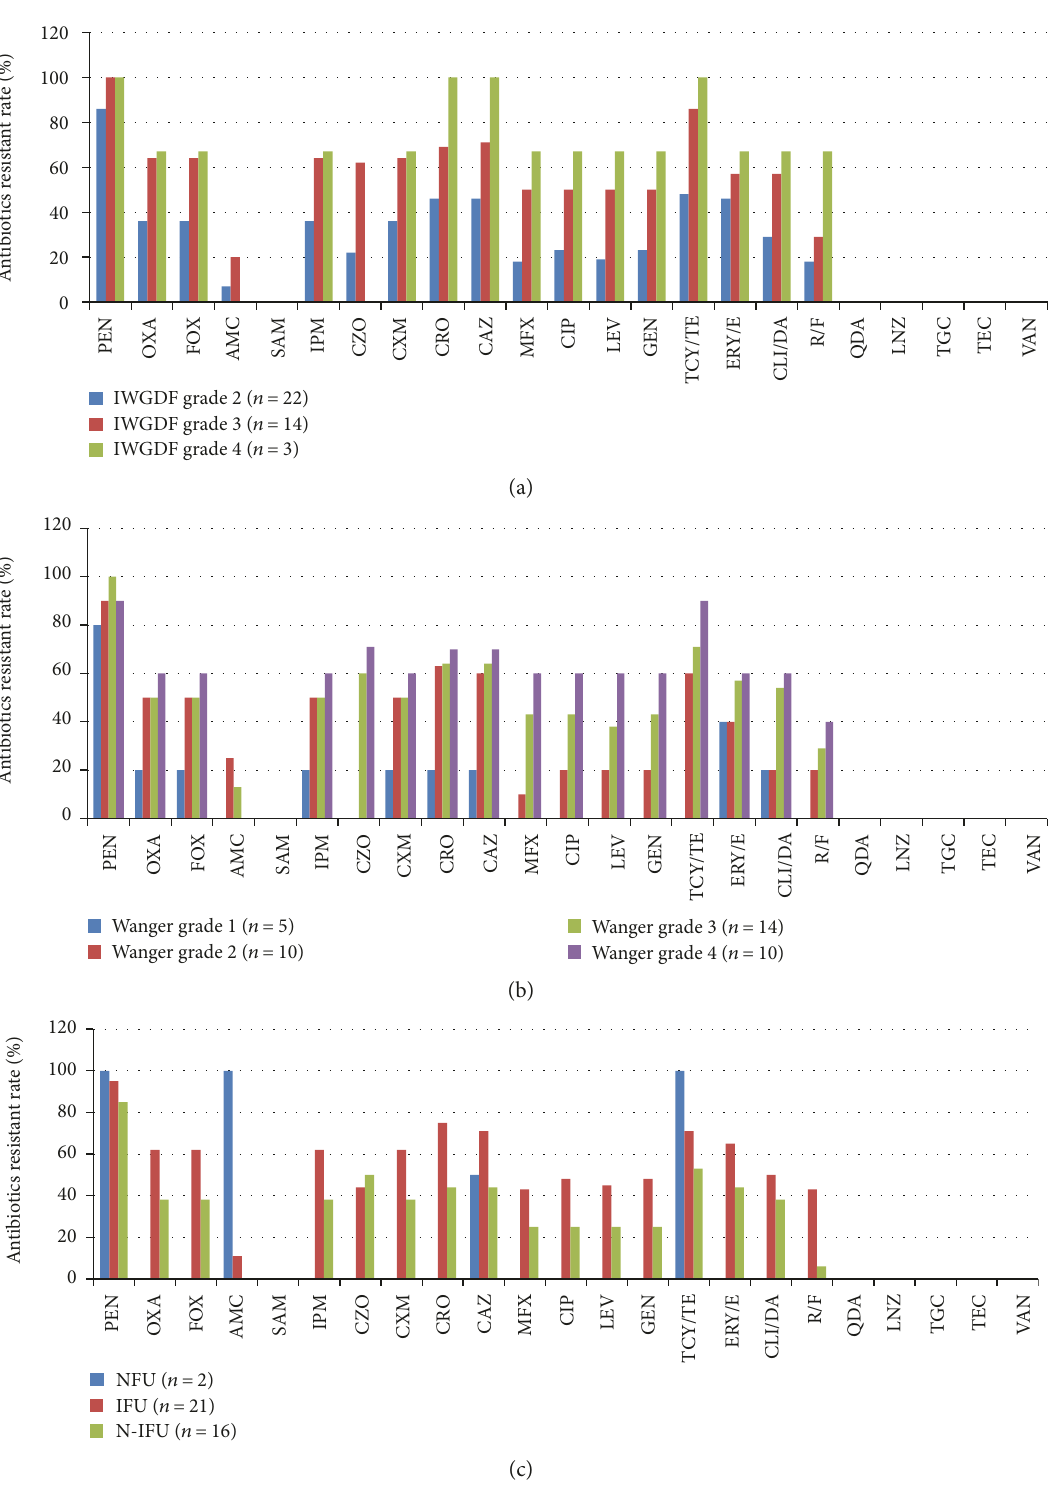
Figure 4: Antibiotic resistance rates of Staphylococcus aureus isolated in DFI in di ff erent Wagner ’ s grades, IDSA/IWGDF grades, and DFU types. (a) Antibiotic resistance rates of Staphylococcus aureus isolated in di ff erent IDSA/IWGDF grades ’ DFIs; (b) antibiotic resistance rates of Staphylococcus aureus isolated in di ff erent Wagner ’ s grades ’ DFIs; (c) antibiotic resistance rates of Staphylococcus aureus isolated in di ff erent DFU types. PEN, penicillin; OXA, oxacillin; FOX, cefoxitin; AMC, amoxicillin/clavulanate; SAM, ampicillin/sulbactam; IPM, imipenem; CZO, cephazolin; CXM, cefuroxime; CRO, ceftriaxone; CAZ, ceftazidime; MFX, moxi fl oxacin; CIP, cipro fl oxacin; LEV, levo fl oxacin; GEN, gentamicin; TCY/TE, tetracycline; ERY/E, erythromycin; CLI/DA, clindamycin; RIF, rifampicin; QDA, quinupristin/dafoeleptin; LNZ, linezolid; TGC, tigecycline; TEC, teicoplanin; VAN,